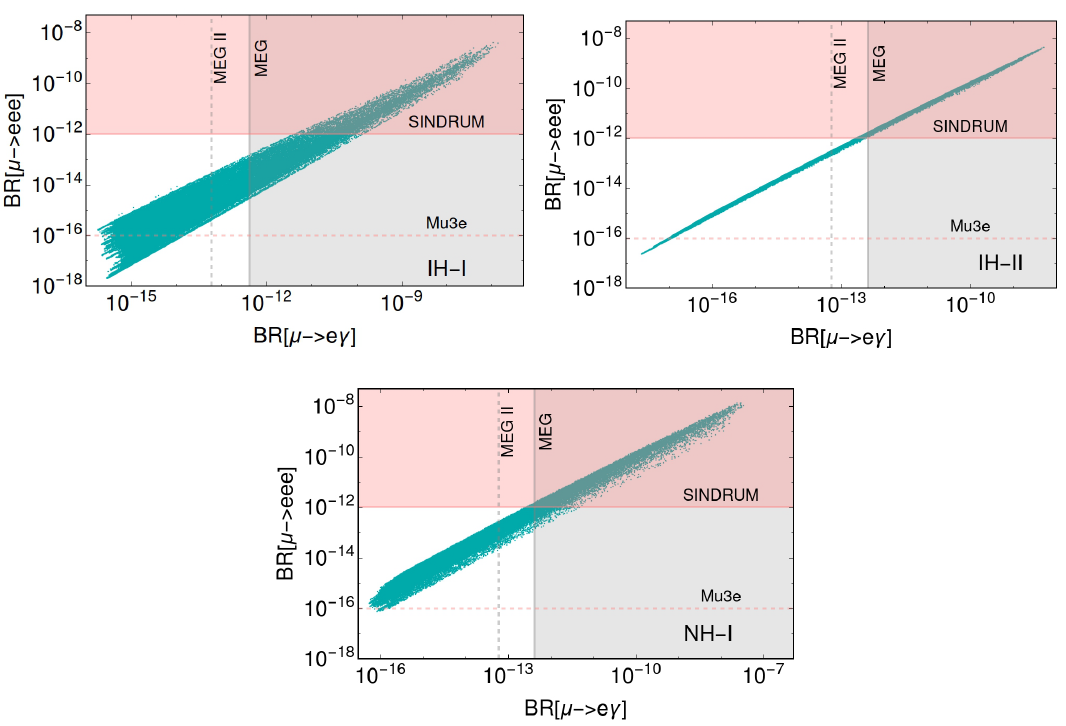
Figure 7 . Correlations between µ → eγ and µ → eee . Shaded colored regions are ruled out by current data and dotted lines represent future